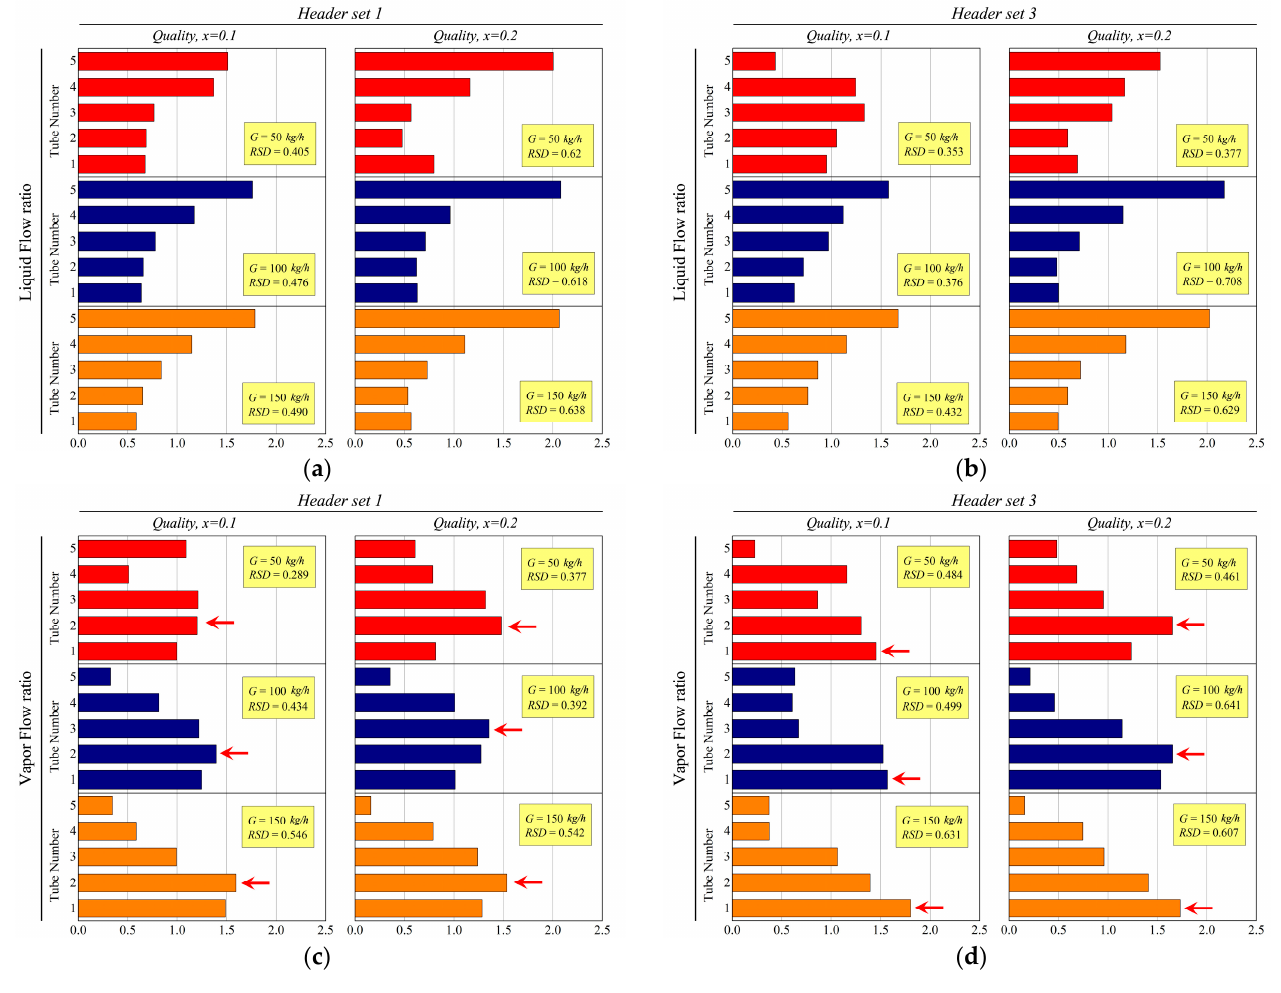
Figure 7. Effect of inlet quality to flow distribution profile: ( a ) liquid flow ratio, the header set 1 (190 mm); ( b ) liquid flow ratio, the header set 3 (490 mm); ( c ) vapor flow ratio, the header set 1 (190 mm); ( d ) vapor flow ratio, the header set 3 (490 mm).